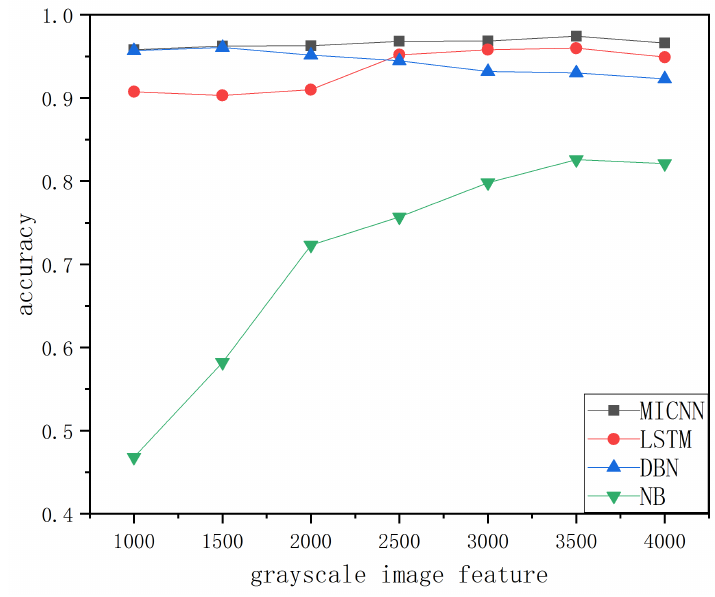
Figure 6. Simulation of gray image.